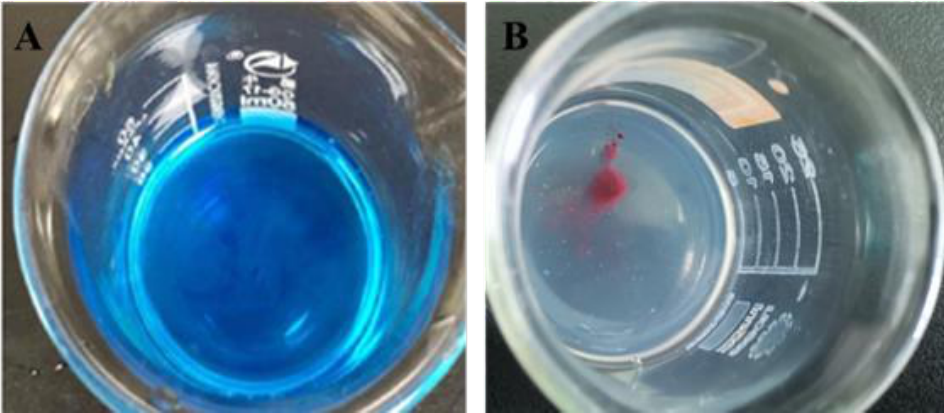
Figure 1. Evaluation of CE-NE type, ( A ) is diffusion after the addition of methylene blue, ( B ) is diffusion after the addition of Sudan red.